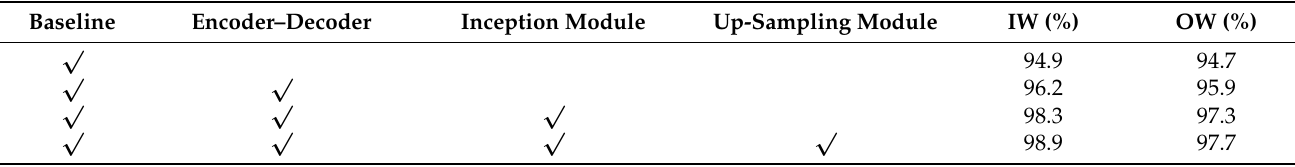
Table 1. Ablation experiment results on